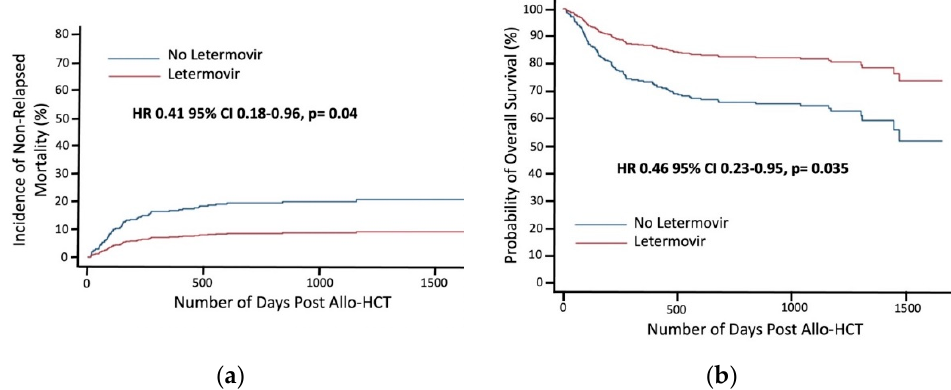
Figure 2. Survival outcomes in patients treated with or without letermovir prophylaxis: ( a ) Gray’s test was used to estimate non-relapsed mortality; ( b ) Kaplan-Meier method was used to estimate overall survival.